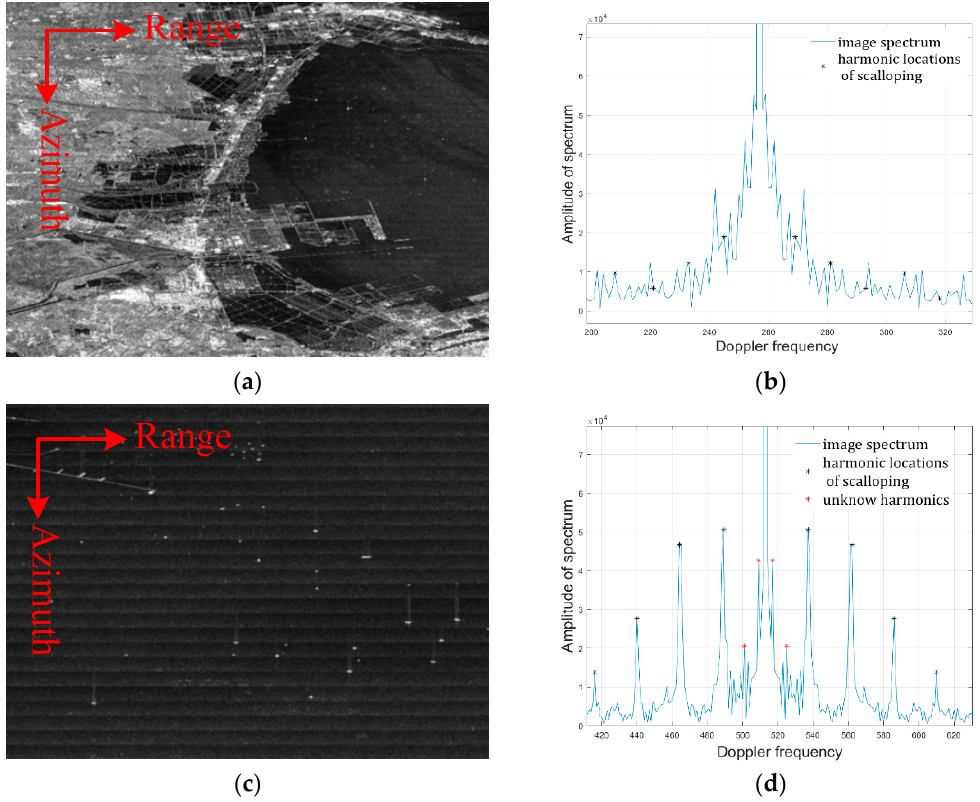
Figure 9. Spectrum characteristics of scalloping in non-uniform scene: ( a ) the region near Bohai bay of Frame 1 in Figure 8; ( b ) the scalloping spectrum of (a); ( c ) the region with densely distributed vessels of Frame 2 in Figure 8; ( d ) scalloping spectrum of (c).